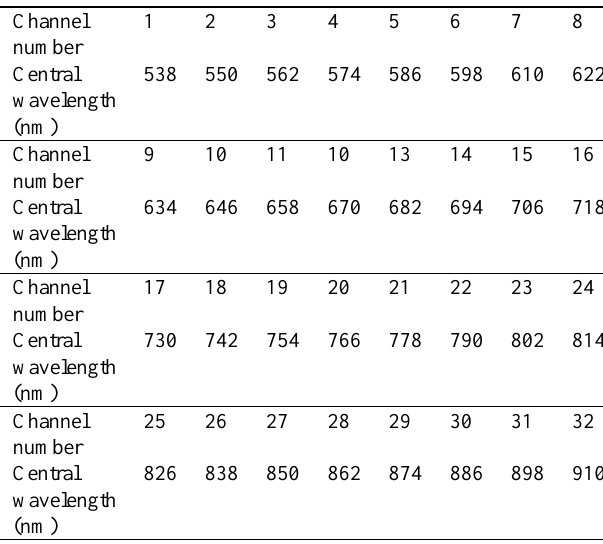
Table 2 Centre wavelengths of this HSL system.